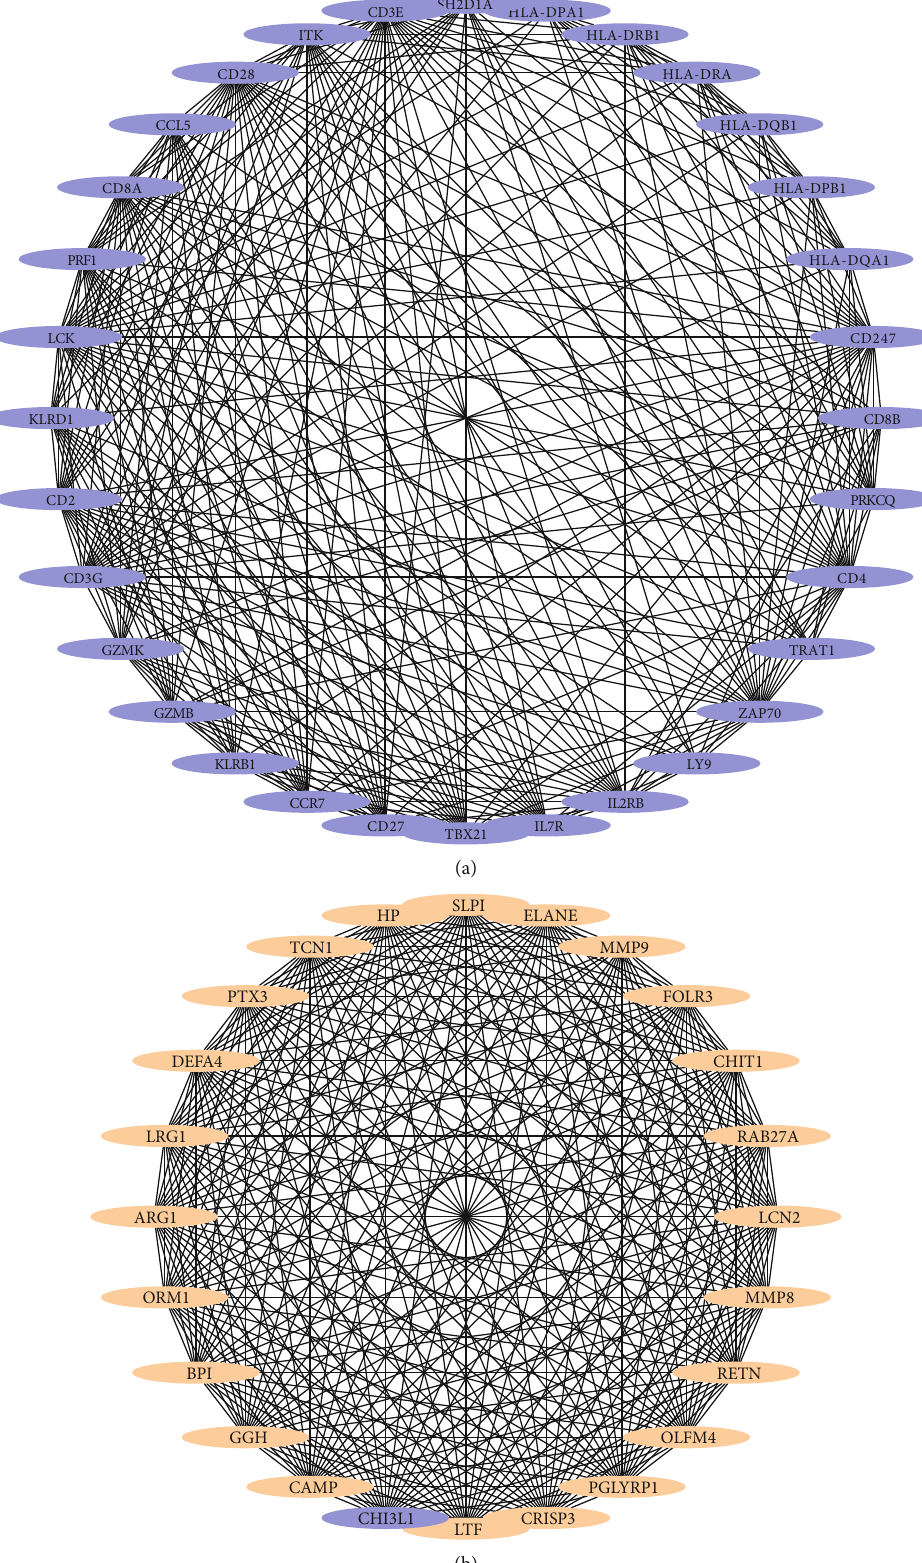
Figure 4: Clusters A and B identi fi ed by network analysis. The PPI network is divided into 2 clusters by the MCODE plugin. Light orange and bluish violet represent upregulated and downregulated genes